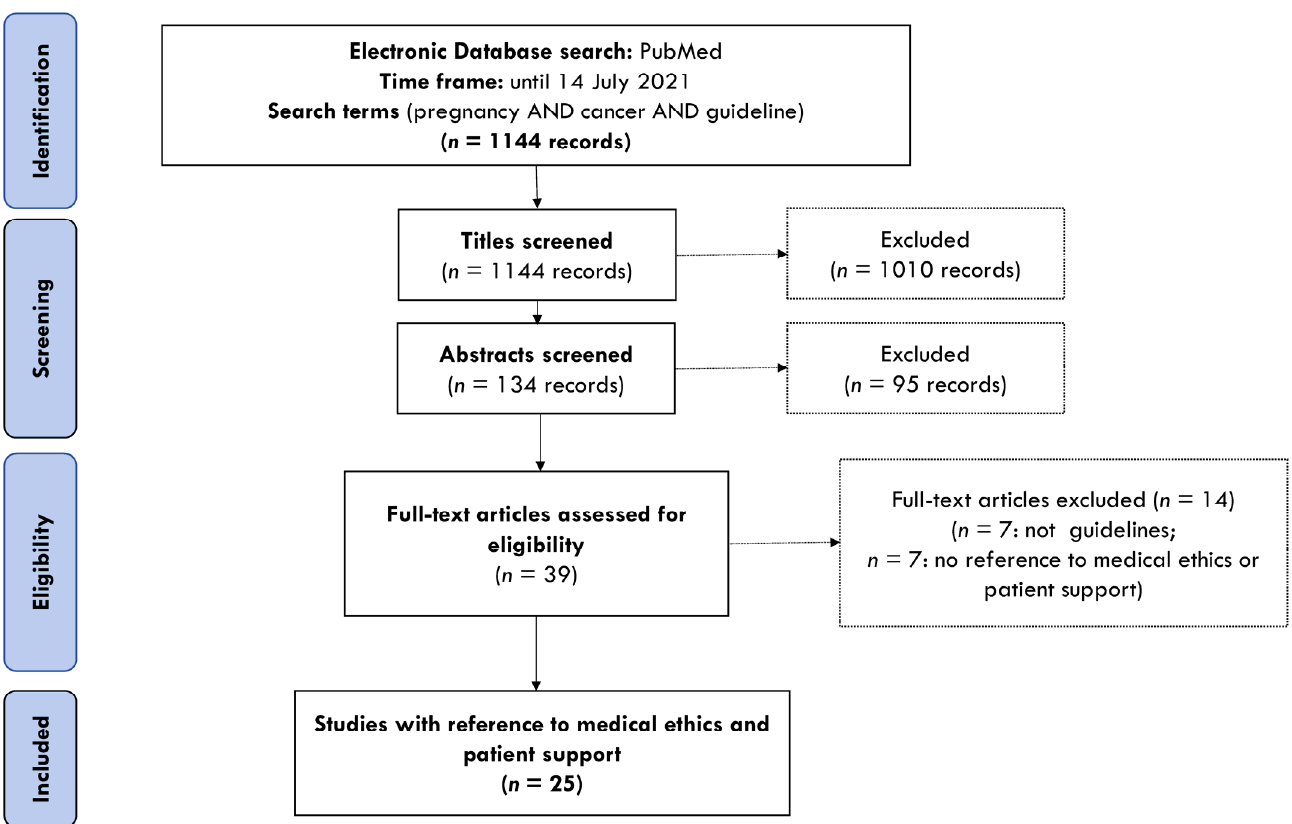
Figure 1. Study Flowchart.